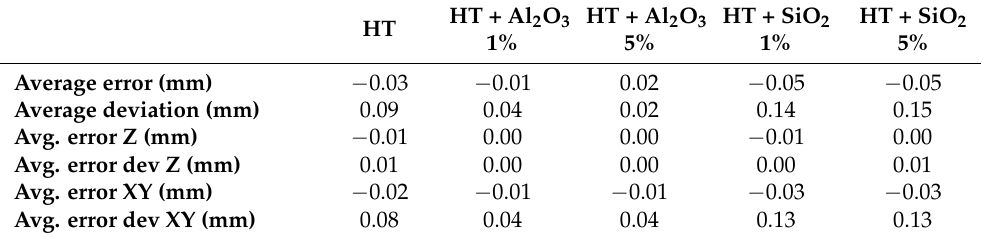
Table 3. Measurement analysis for outward features.